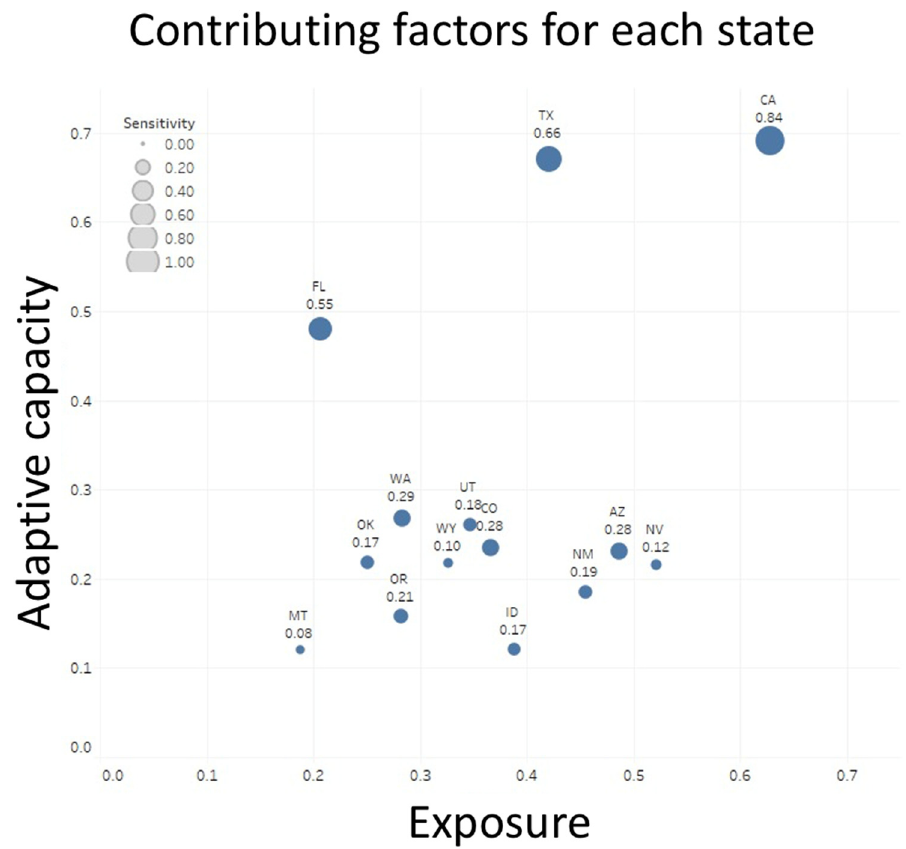
Figure 8. Plot showing the overall contributing factors for each state, indicated by exposure (along the x axis); adaptive capacity (along the y axis); and sensitivity (denoted by the size of the circles).